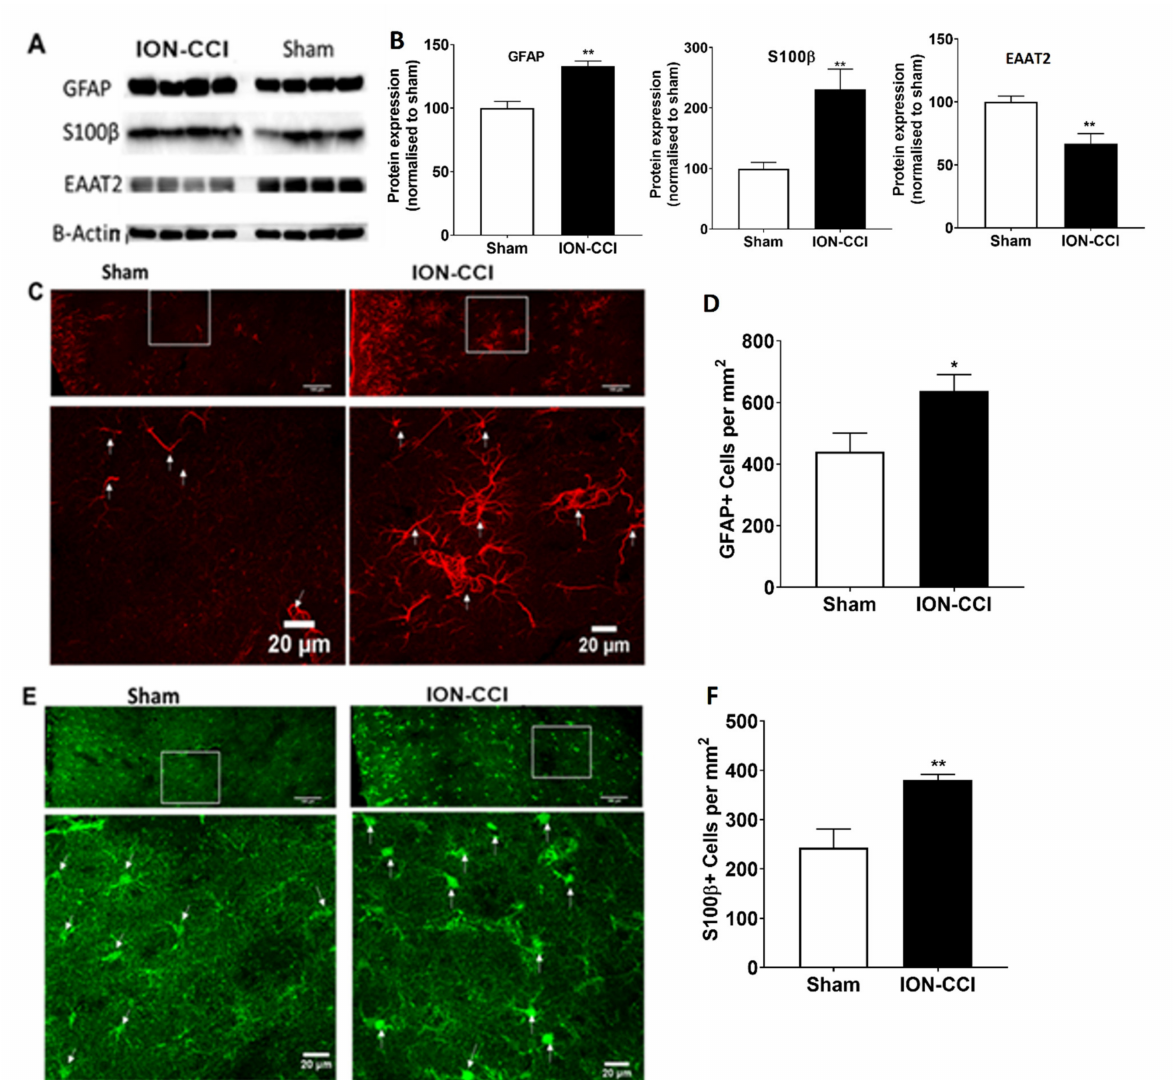
Figure 6. Astrogliosis in the anterior cingulate cortex (ACC) region in ION-CCI and sham-operated rats. ( A ) Brain tissue extracts were collected 30 days after the ION-CCI surgery or sham surgery. Immunoblot images showing GFAP, S100 β , and EAAT2 protein bands from the ACC tissue lysate extracts obtained from ION-CCI and sham-operated rats. ( B ) GFAP and S100 β protein content were increased in the ION-CCI rats, and glutamate transporter (EAAT2) was decreased in TNP rats, indicating cortical astrogliosis. ( C ) Representative confocal images showing increase in GFAP+ cells in the ACC. The top panel is at lower resolution showing the whole ACC region analyzed, and the bottom panel is at higher resolution showing layer IV. The white arrow marks point the cells in the ACC region. ( D ) The GFAP+ cells were increased by 44% in ION-CCI rats in the ACC region. ( E ) Representative confocal images showing increase in S100 β + cells in the ACC. The top panel is at lower resolution showing the whole ACC region analyzed, and the bottom panel is at higher resolution showing layer IV. The white arrow marks point the cells in the ACC region. ( F ) The S100 β + cells were increased by 38% in ION-CCI rats in the ACC region. Statistical significance was determined by unpaired t-test, ION-CCI vs. sham, * p < 0.05, ** p <